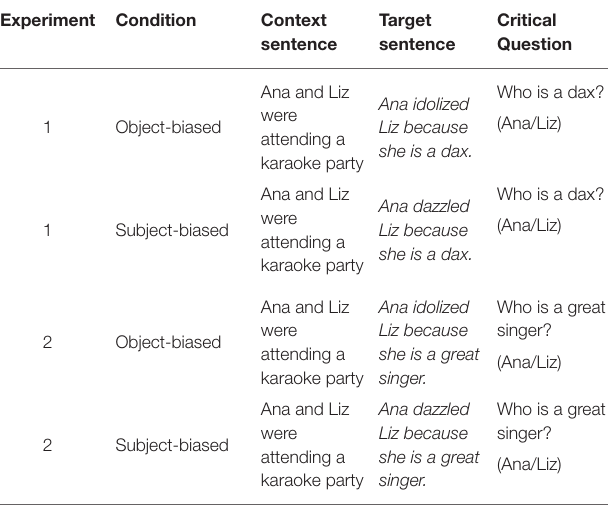
TABLE 1 | One target item appears across two lists, differentiated by verb